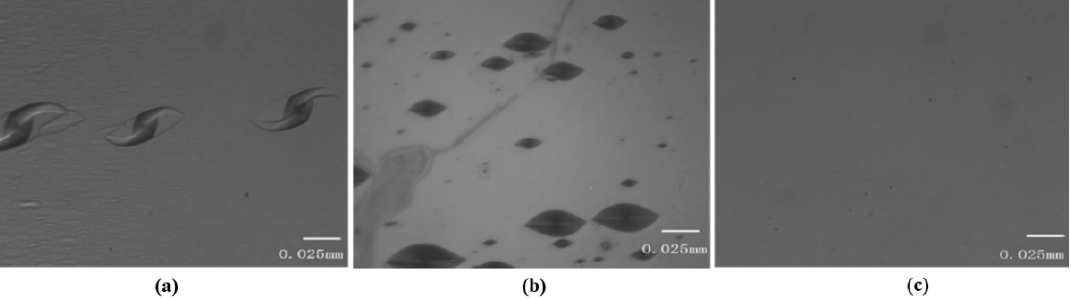
Figure 2. The etch pits on ( a ) (100) plane, ( b ) (001) plane, and ( c ) (010) plane of a CBO crystal.